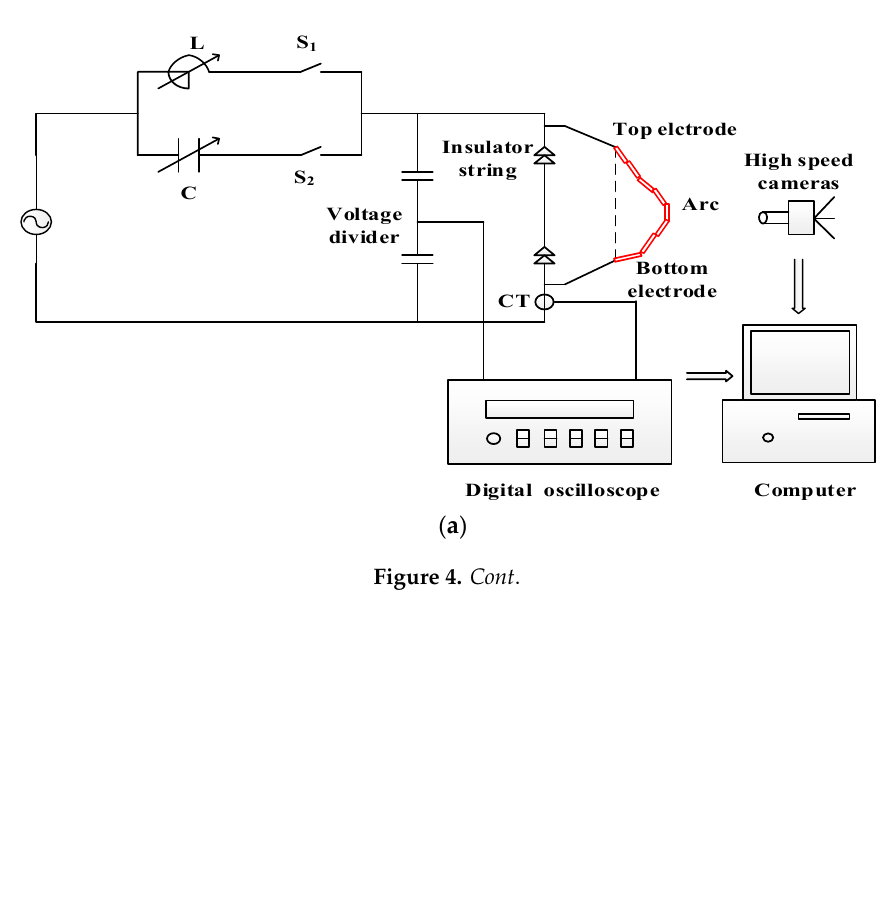
Table 2. Boundary conditions.